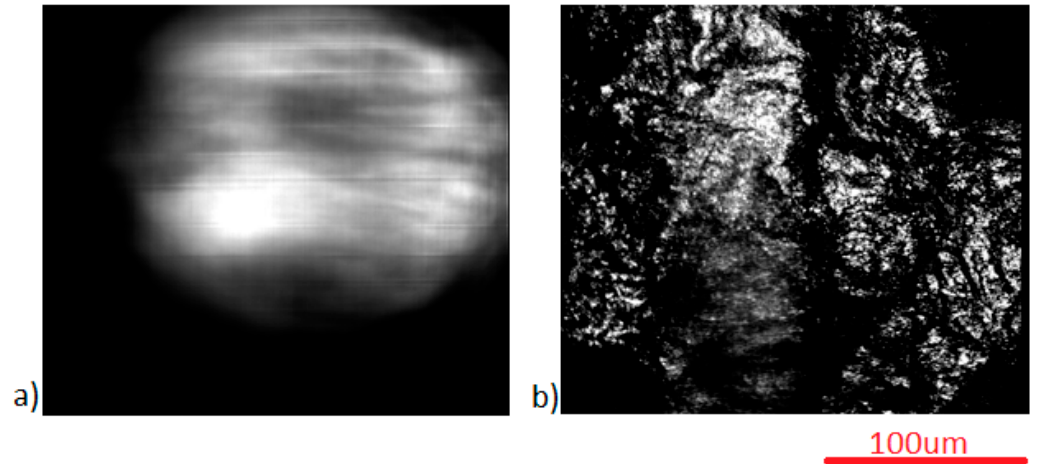
Figure 6. CSLM images taken from the sample cooled in a CO 2 atmosphere, taken at ( a ) 0 s (liquid steel) and ( b ) 25 s (oxide film) according to Figure 5.